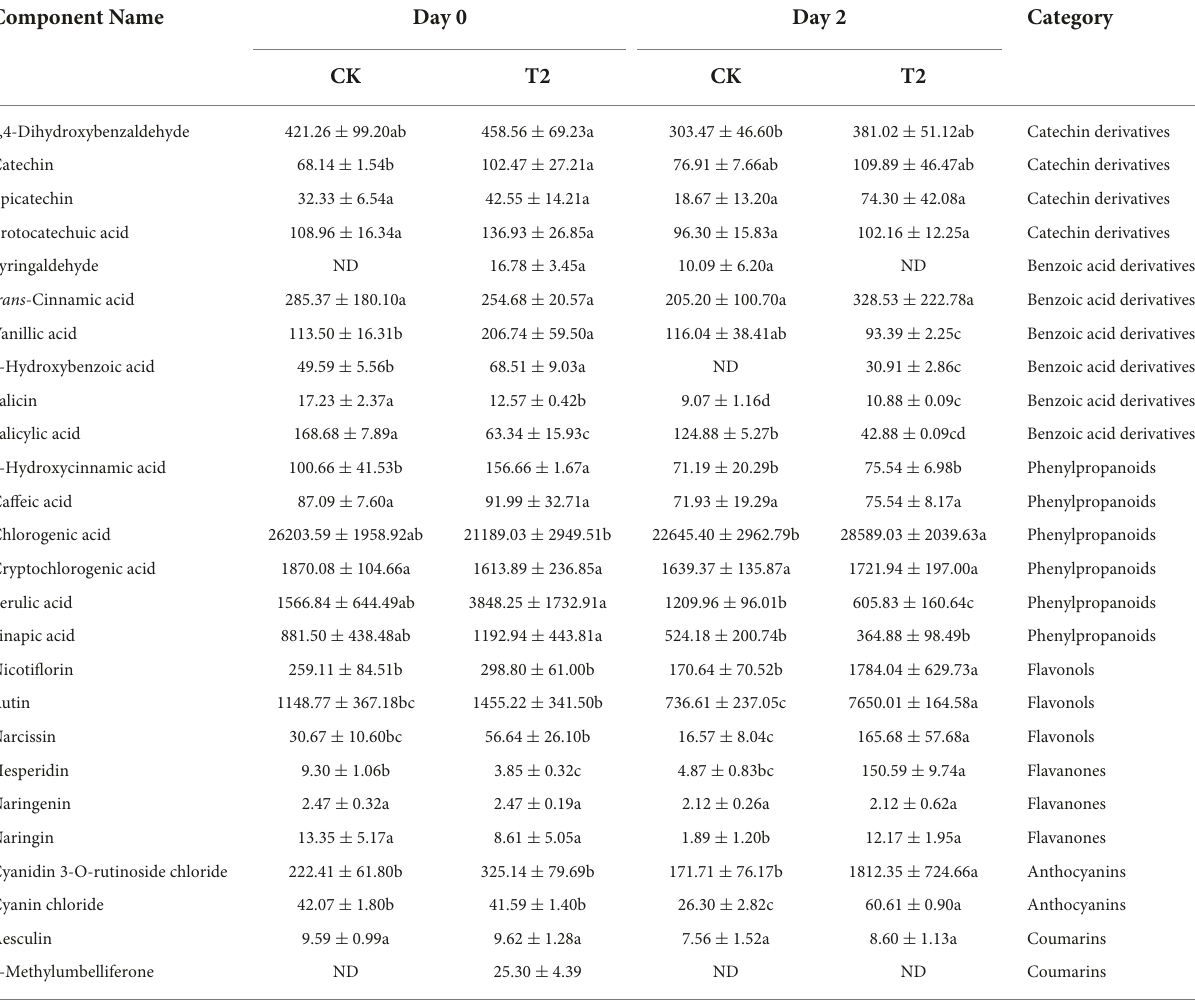
TABLE 4 Effects of ozone treatment on individual phenolic compounds of fresh-cut pitaya fruits during